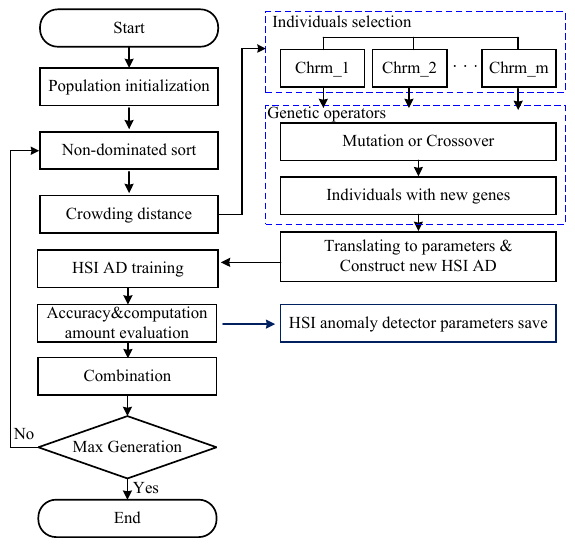
Figure 15. The basic flow of the